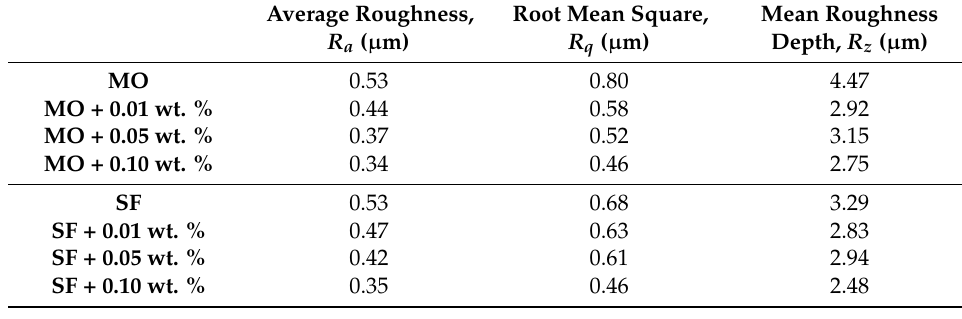
Figure 10. Roughness profiles and Ra values of worn blocks for SF + HNT nanofluidos: ( a ) SF; ( b ) SF + 0.01 wt. % HNTs; ( c ) SF + 0.05 wt. % HNTs; ( d ) SF + 0.10 wt. % HNTs. Arrows indicate the direction of sliding. Table 2. Comparison of surface roughness characteristics of block materials. Table 2. Comparison of surface roughness characteristics of block materials.